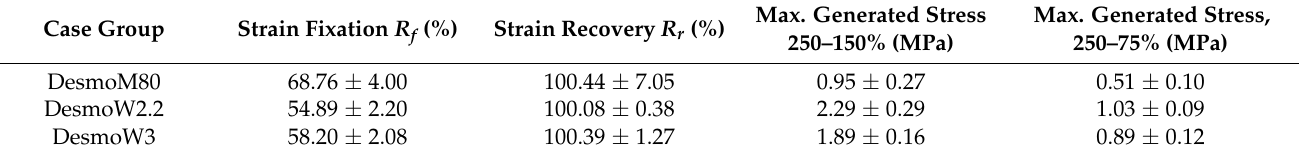
Table 2. Characteristics of SME of analyzed Desmopan–PCL–bend